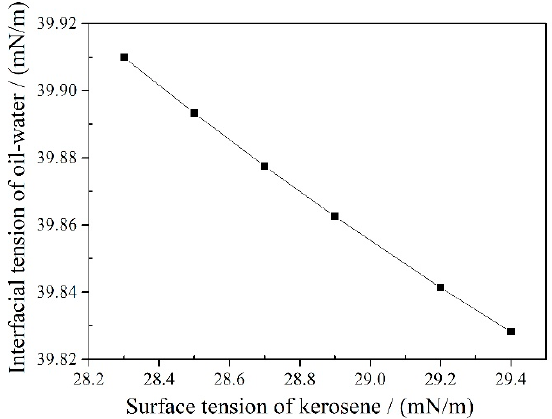
Figure 7. The relationship between the surface tension of kerosene and the interfacial tension of kerosene–water (298 K).